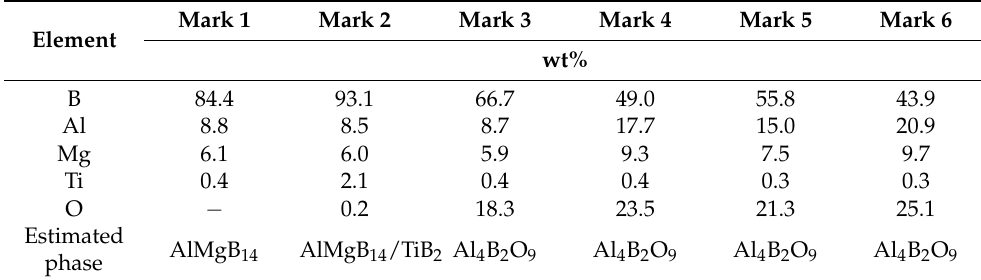
Table 5. Spectra of elements in selected places on the surface of the AlMgB 14 -TiB 2 composite. Element